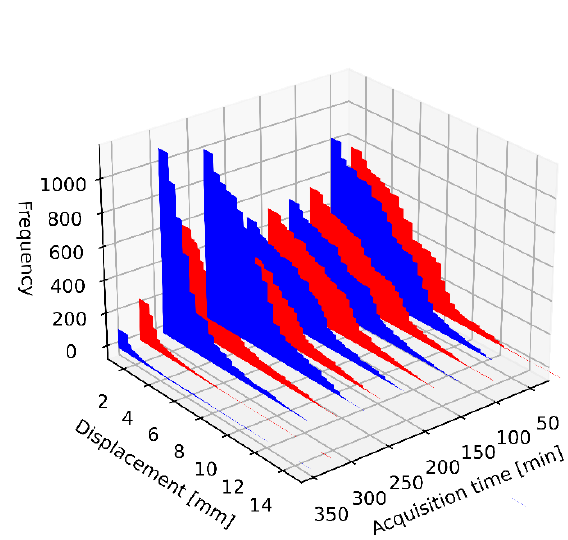
Figure 5 . Changing over time (30 minutes steps) of the displacement values distributions during the drying process of the